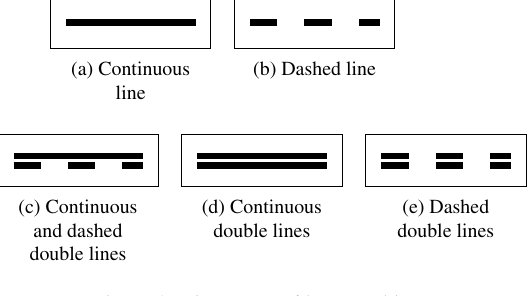
Figure 2. Line types of lane markings